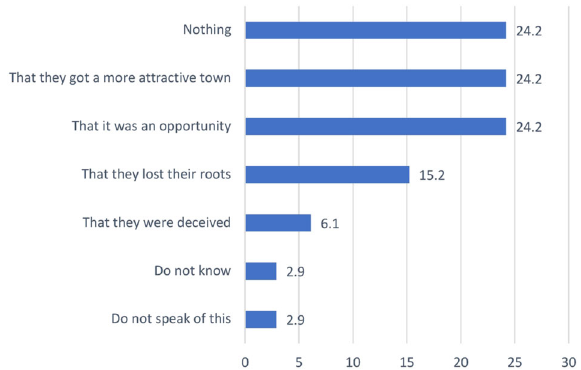
Fig. 6 Local community. Inhabitants of Old Portomarín. What do you think the young people think about the forced